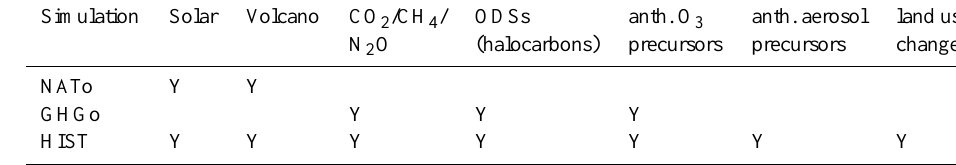
Table 1. Summary of CMIP5 experiments for the historical (1850–2005) period used in this study. Simulation